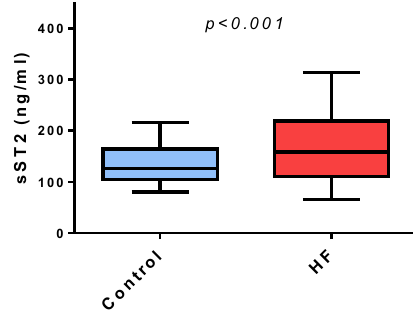
Figure 1. Serum levels of soluble Suppression of Tumorigenesis-2 are higher in the heart failure group compared to the control group. The Distribution of serum levels of soluble Suppression of Tumorigenesis-2 are shown with Box-plots sST2: Soluble Suppression of Tumorigenesis-2.